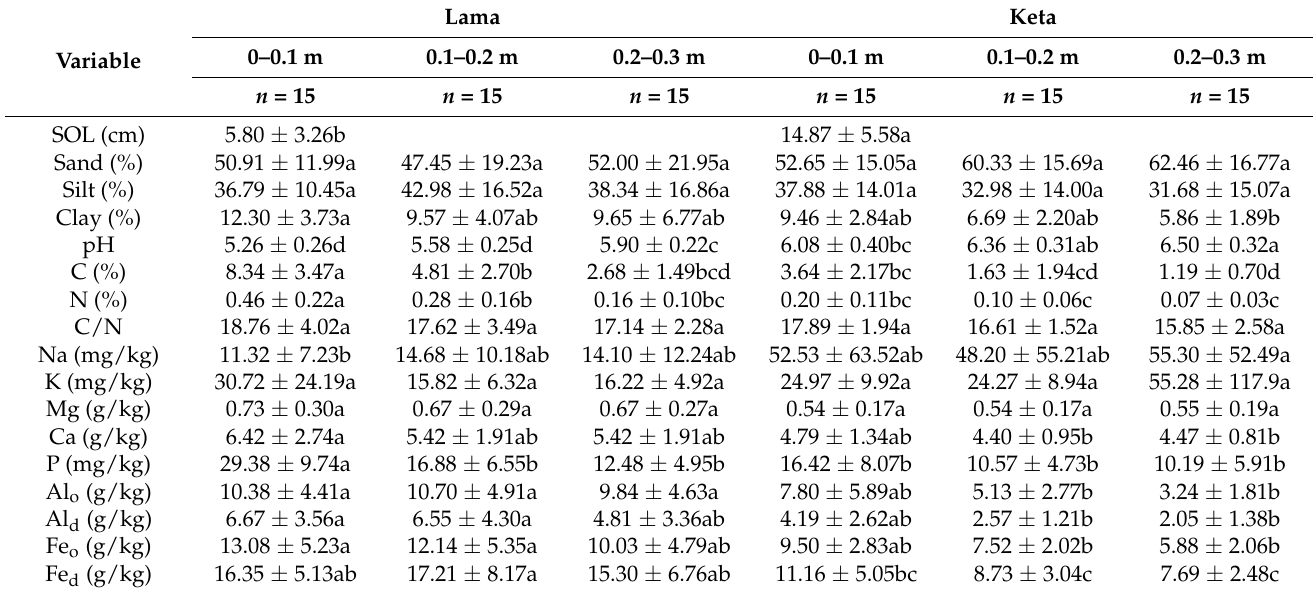
Table 4. Soil properties at two localities and of different soil layers (mean values, standard deviations, and Tukey pairwise test; means with the same letters do not differ